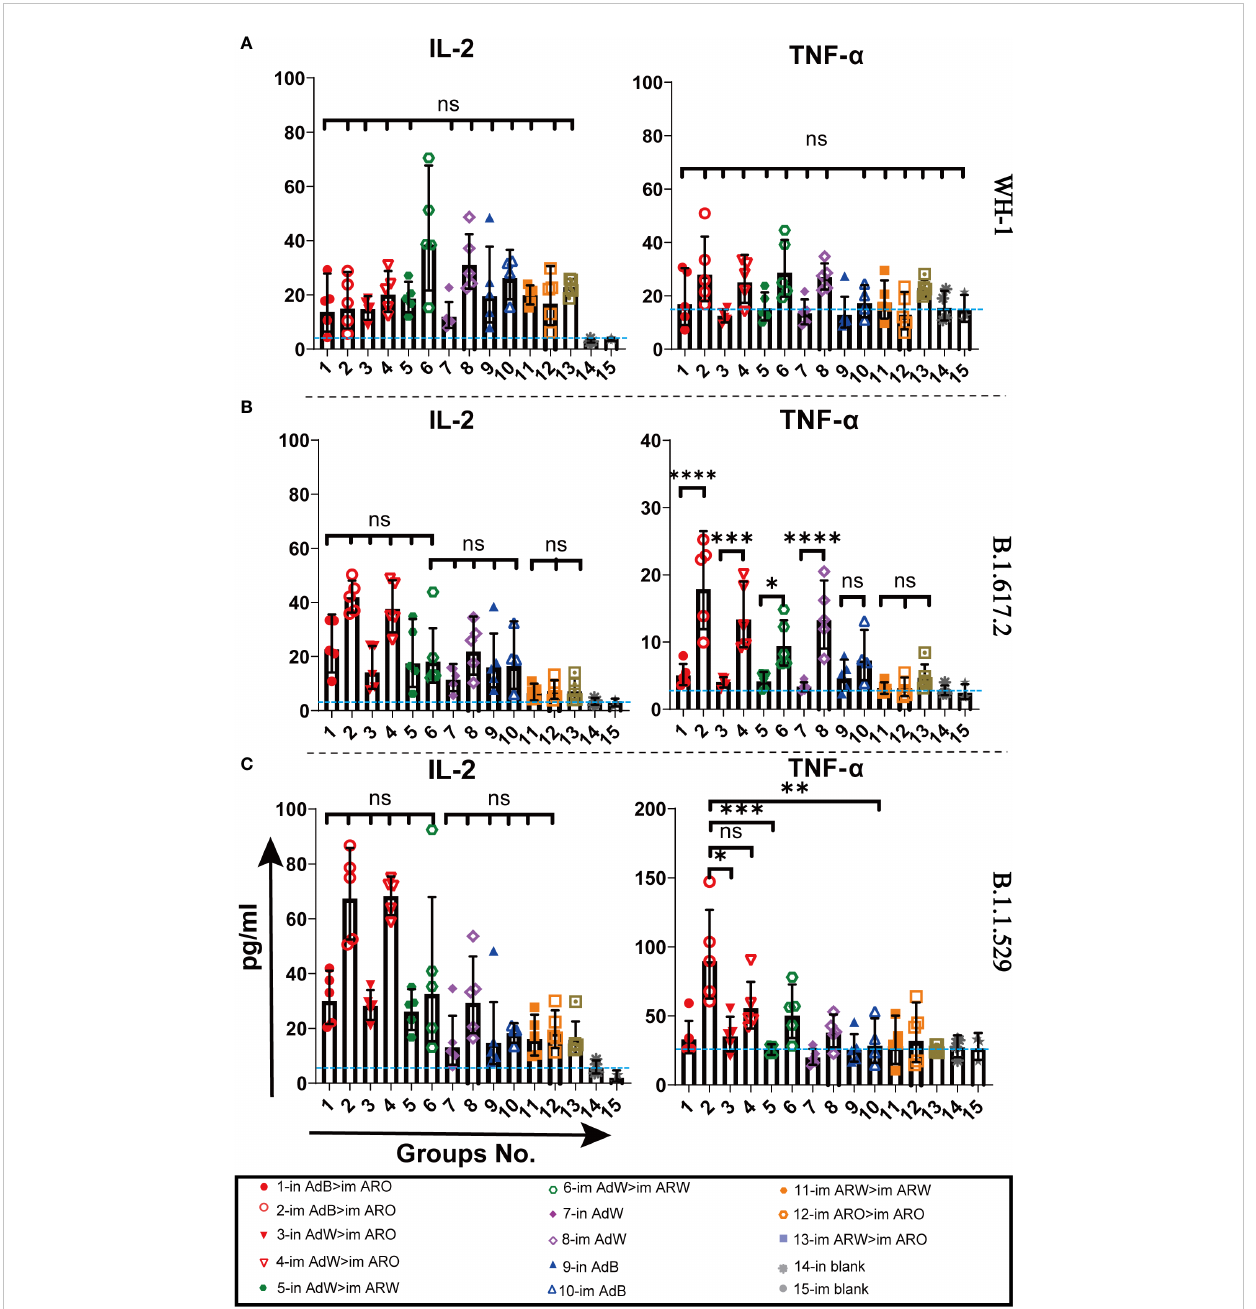
FIGURE 10 Th1/Th2 skewing in immunised mice was measured using Meso Scale Discovery (MSD) cytokine pro fi ling. Lymphocytes were stimulated with (A) WH-1, (B) B.1.617.2, and (C) B.1.1.529 spike peptide pools spanning the entire spike protein sequence for 24 h. IL-2 and TNF- a levels in supernatants were measured (n = 5 per group; each point represents one sample). Bars represent the geometric mean ± geometric SD; *P < 0.05; **P < 0.01; ***P < 0.001; ****P < 0.0001; ns, P > 0.05. The blue dashed lines represent the blank